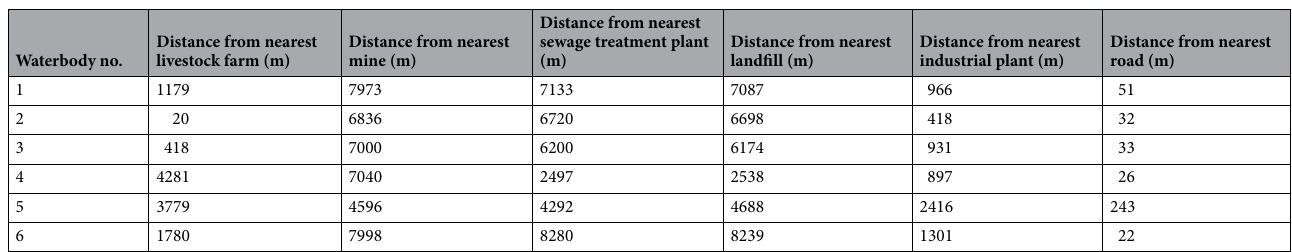
Table 4. The shortest distance from potential sources of